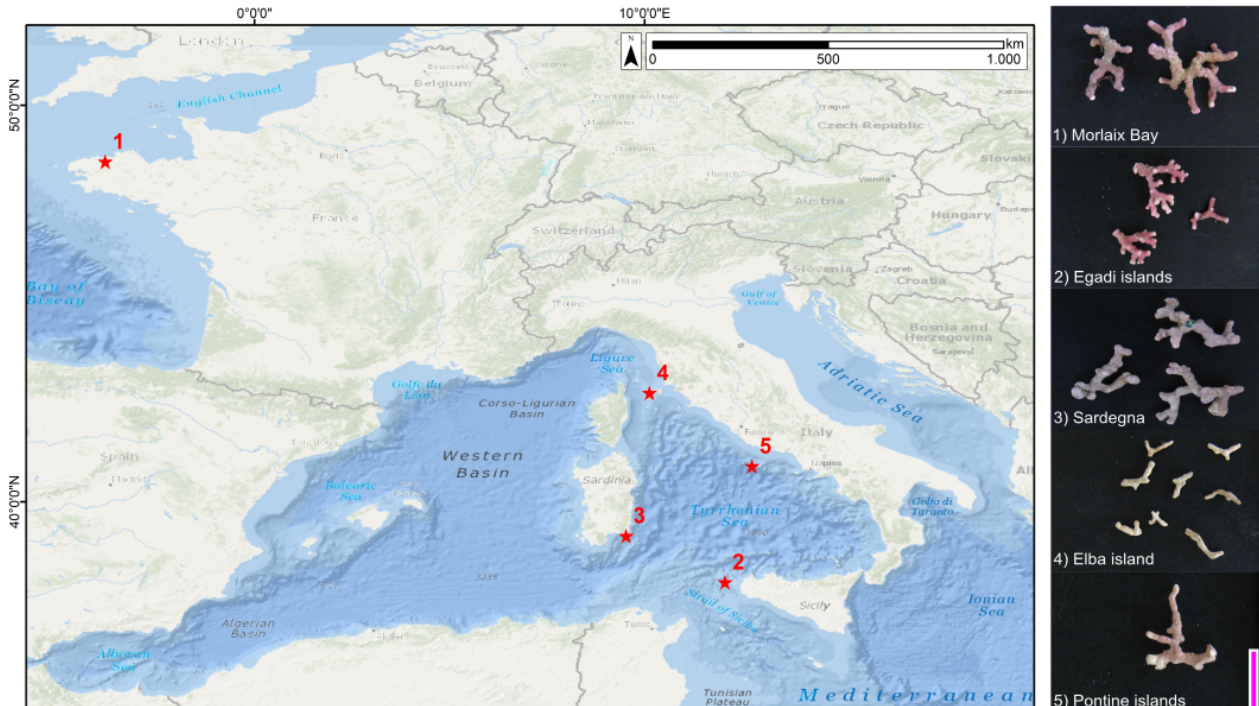
Figure 1. Sampling sites (1–5) and images of selected samples. Service layer credit sources: Esri, GEBCO, NOAA, National Geographic, Garmin, HERE, Geonames.org and other contributors. Scale bar =